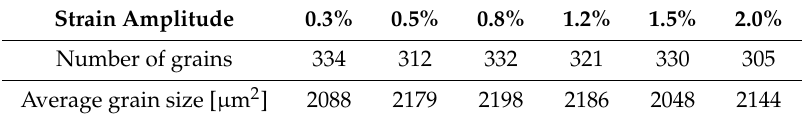
Table 3. Distribution of the relationship between strain and average grain